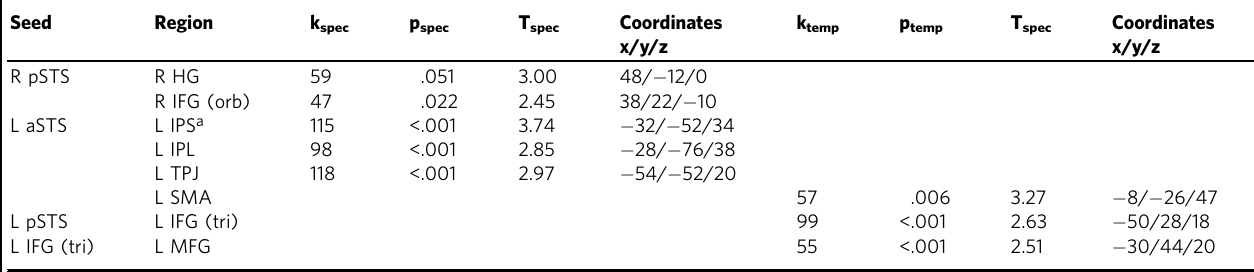
Table 3 Resting-state functional connectivity between seeds and the whole brain associated with spectral (columns three to six) and temporal (columns seven to ten) sensorimotor adaptation (conjunction over consonant and vowel adaptation), cluster corrected for multiple comparisons at p < 0.05 with a cluster de fi ning threshold of p < 0.001 (one-sided, paired t -test, n = 22 participants per group).